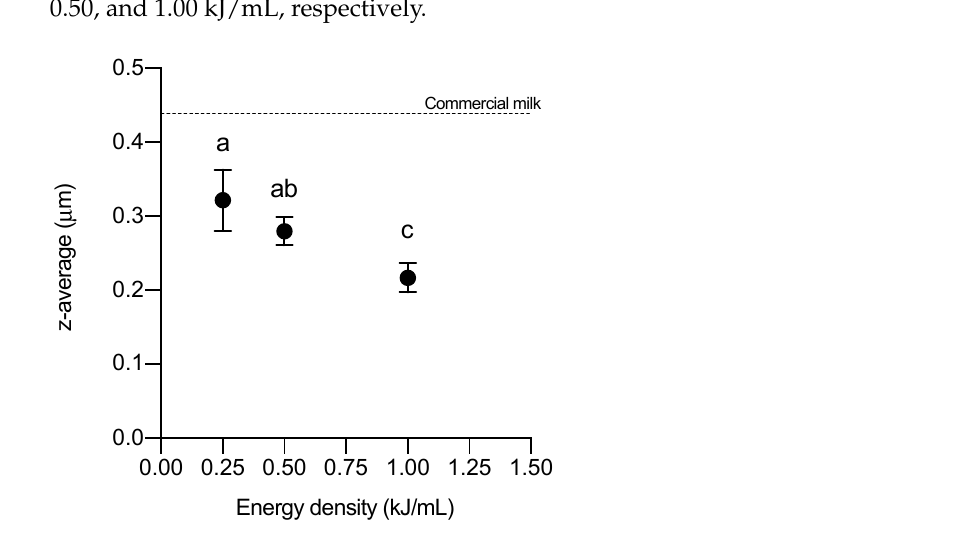
Figure 2. Average size ( z -average) of milk fat globules after the application of three different ultrasonic intensities. The same lowercase letter indicates that there are no significant differences ( p = 0.05).